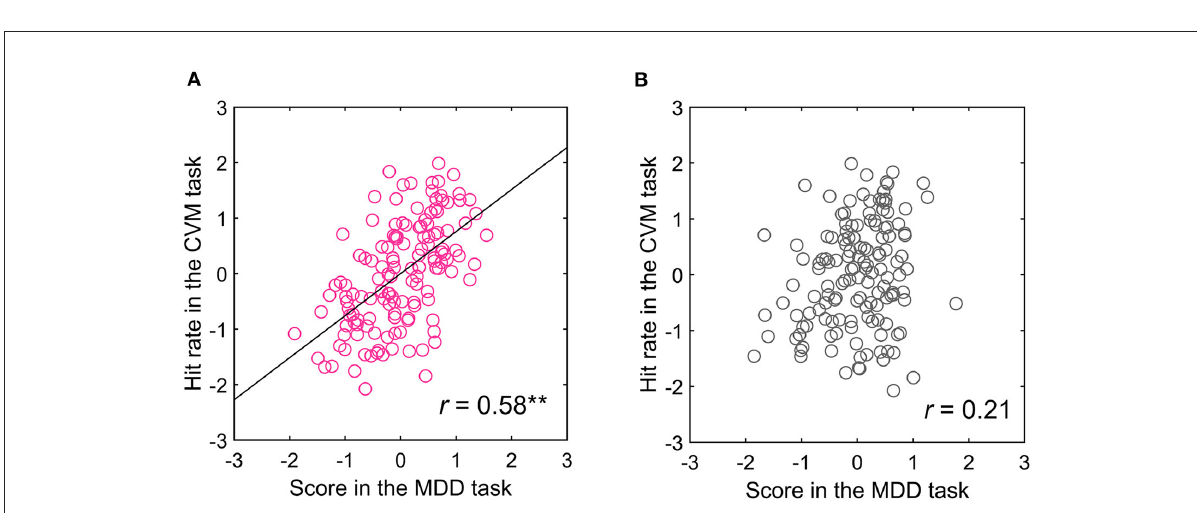
FIGURE8 Relationship between the (A) TAV and (B) non-TAV hemifield scores in the MDD task at C70 and CVM task at 5000 pixels/s. ** p <